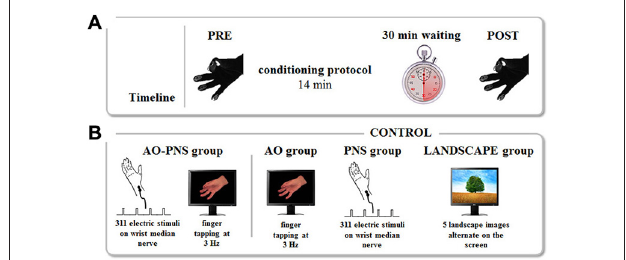
FIGURE 1 | Experimental protocol. (A) Timeline. The kinematics of finger opposition movements were tested before (PRE) and 30 min after (POST) each conditioning protocol by mean of a sensor-engineered glove. (B) Conditioning protocols. The experiment consisted of four conditioning protocols. During Action Observation-Peripheral Nerve Stimulation (AO-PNS) 311 electrical stimulations of the median nerve of the right wrist were administered to the participant while she/he was observing a video showing finger opposition movements paced at 3 Hz: opposition of thumb to index, medium, ring and little fingers. The electrical stimulation was delivered during the thumb-index closing phase. Action Observation (AO), Peripheral Nerve electrical Stimulation (PNS) and LANDSCAPE observation alone were here considered as control conditions. During AO and PNS the subjects either observed the same video (AO group) or received the same electrical stimulation (PNS group) of the AO-PNS group. During LANDSCAPE observation (LANDSCAPE group) participants looked at the computer screen where a sequence of landscape images